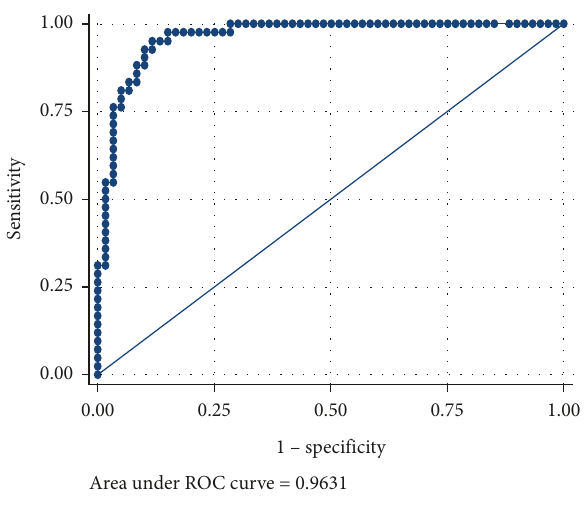
Figure 2: Area under ROC